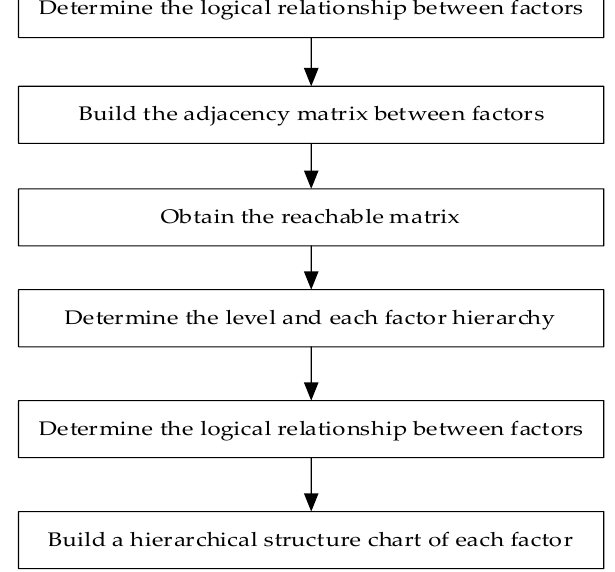
Figure 2. The steps of the ISM.